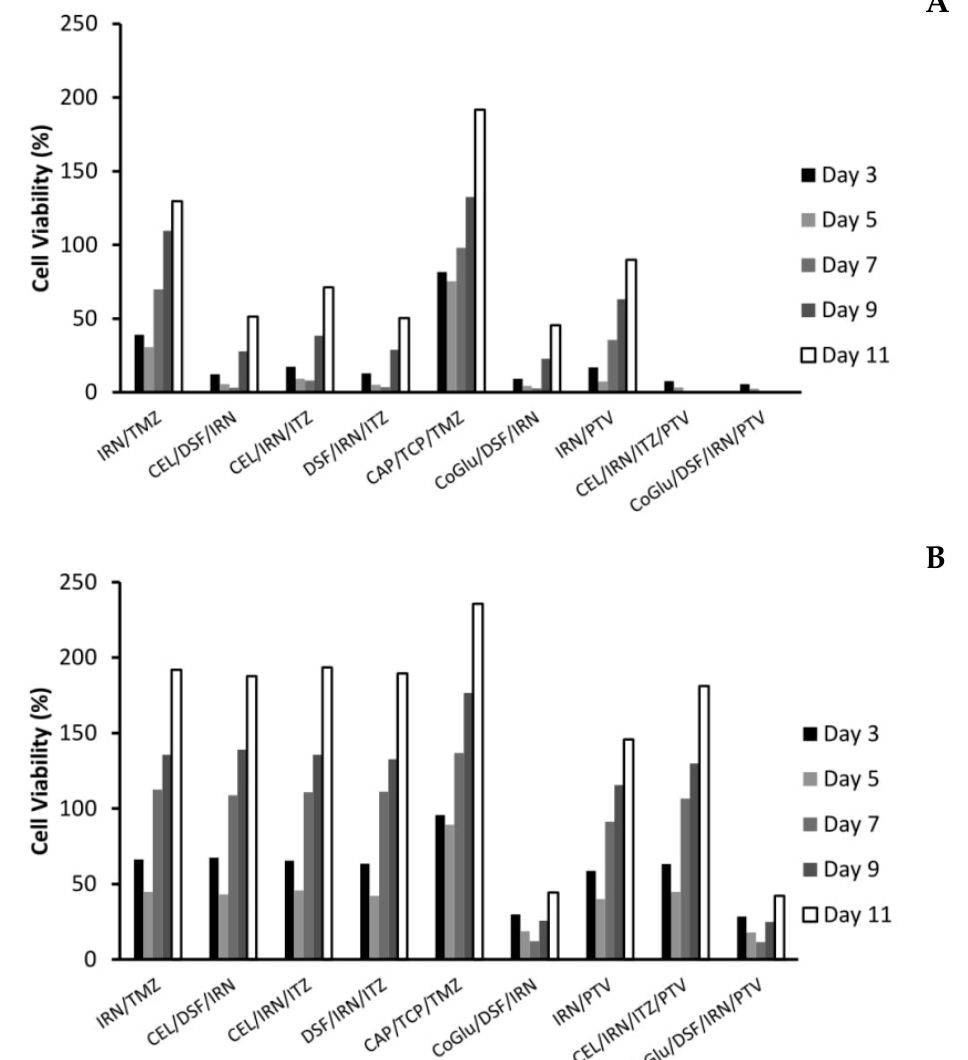
Figure 5. The influence of the combinations on the recurrence rate of GBM 4 ( A ) and GBM 1 ( B ) over an 11-day period. The concentration of each drug in the combination was 5 log nM.